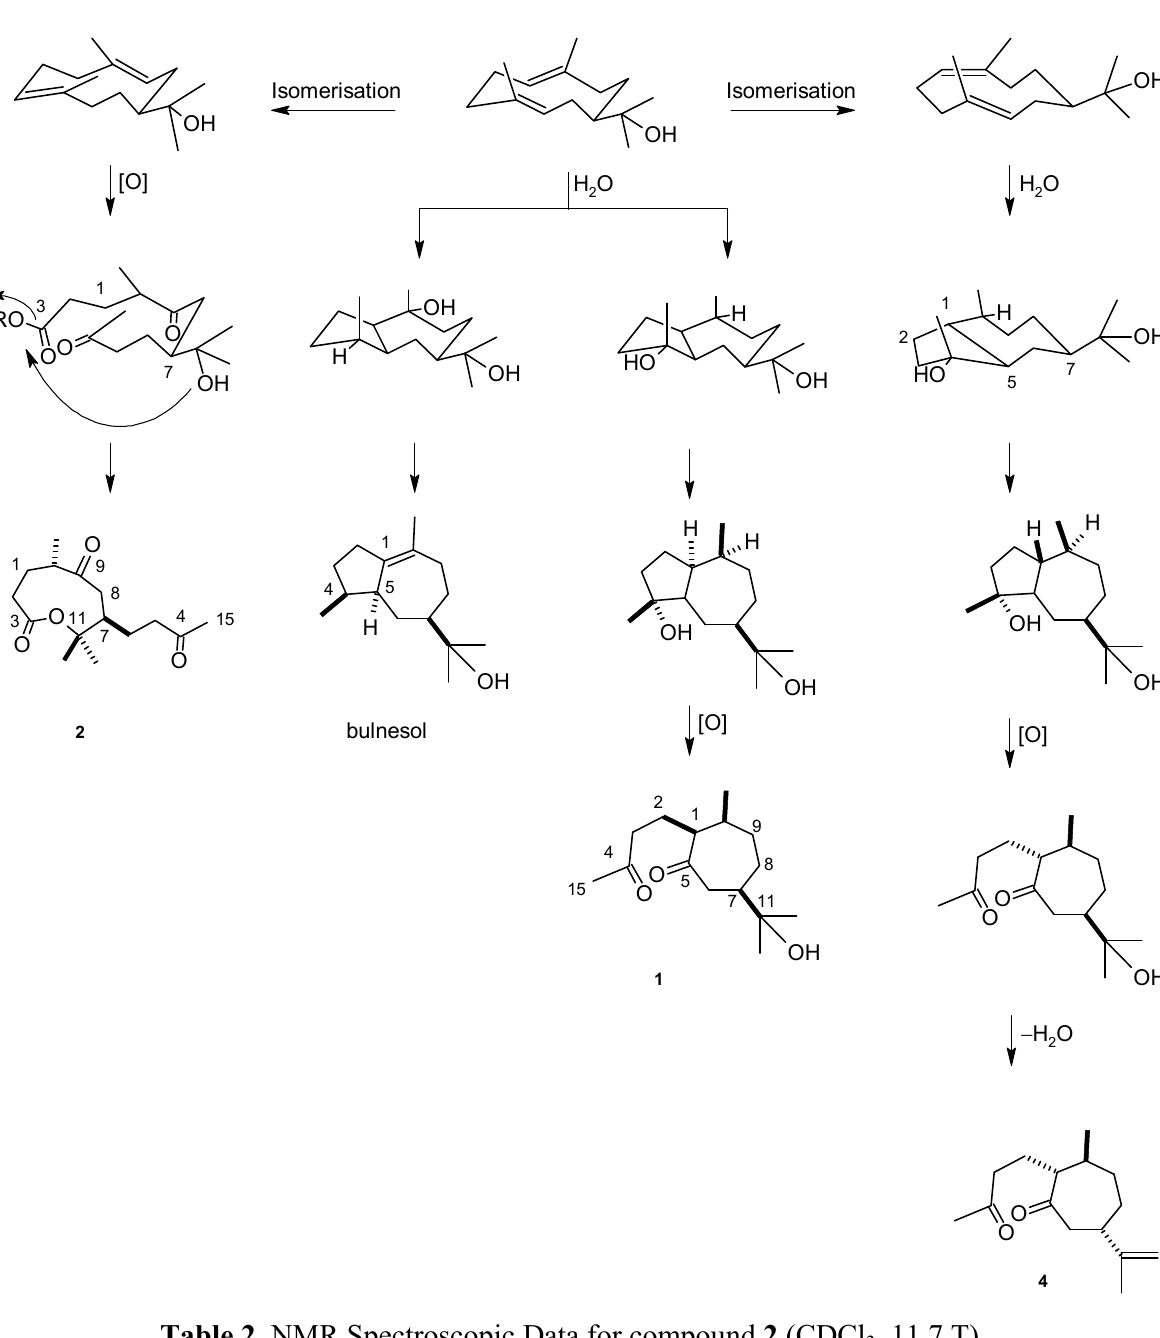
Table 2. NMR Spectroscopic Data for compound 2 (CDCl